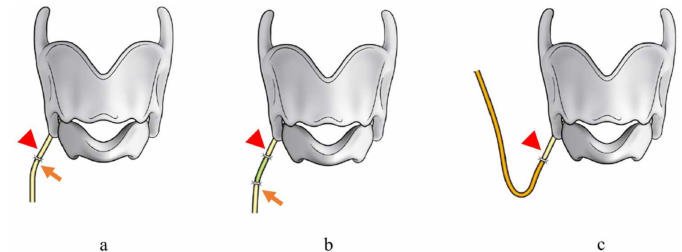
Figure 2. Recurrent laryngeal nerve (RLN) reconstruction procedures. Arrows show proximal edges of right RLN. Arrow heads show distal edges of right RLN: ( a ) direct anastomosis, ( b ) nerve interposition, ( c ) nerve transfer (Citation: Ref. [30]).